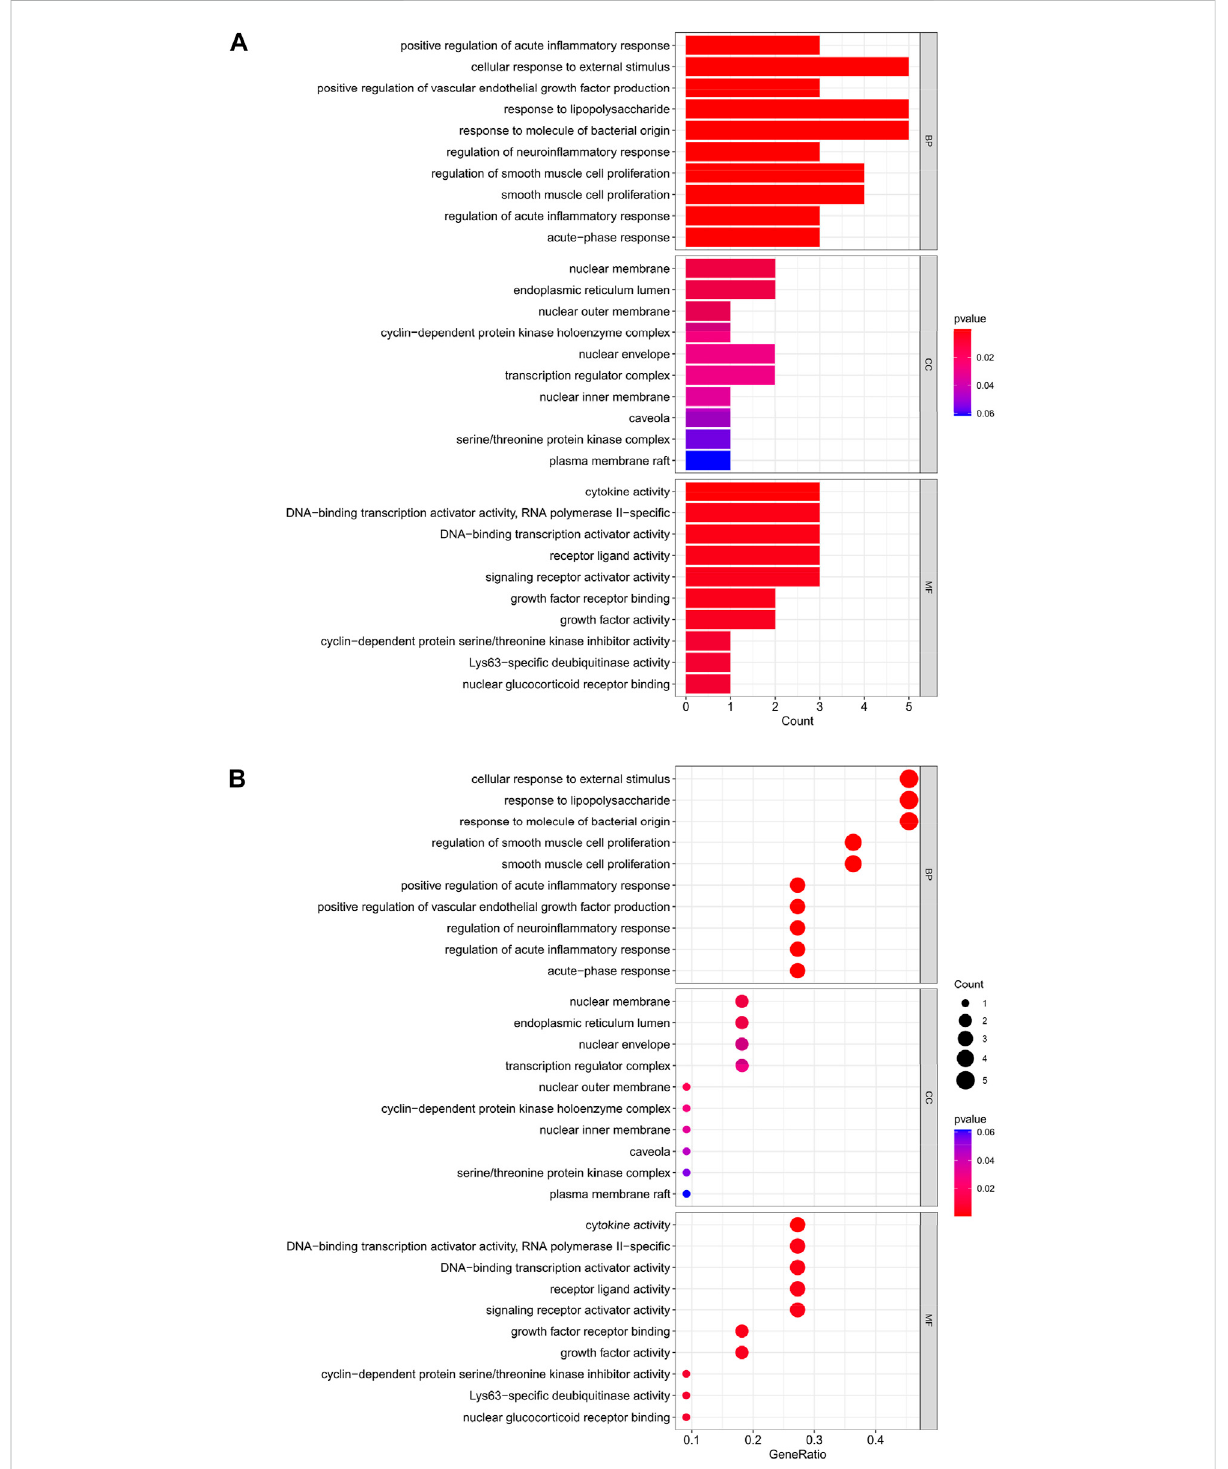
FIGURE 3 (A) Bar chart plotted against the results of GO analysis for the 11 genes in Table 1, (B) Bubble chart plotted against the results of GO analysis for the 11 genes in Table